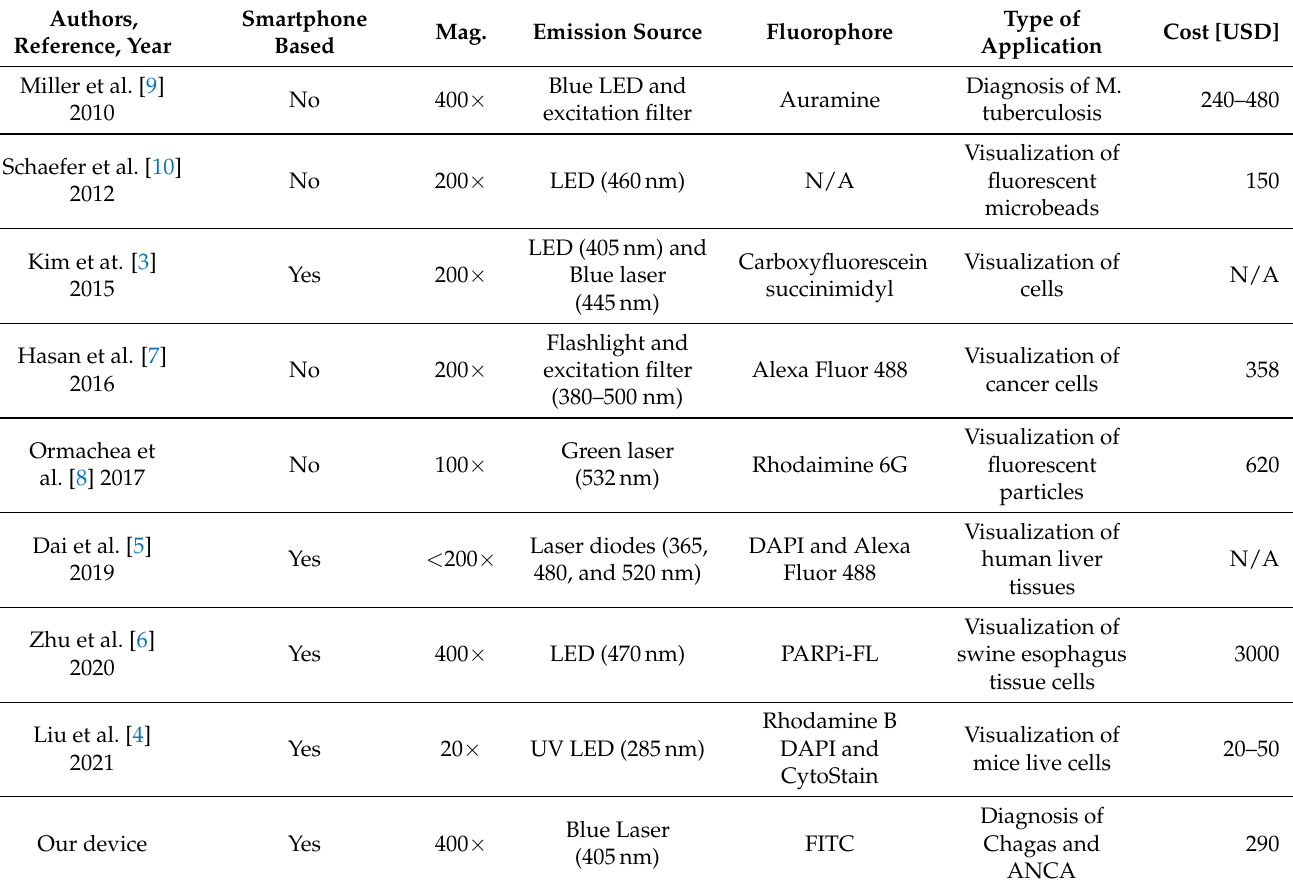
Table 2. Related work on low-cost fluorescence